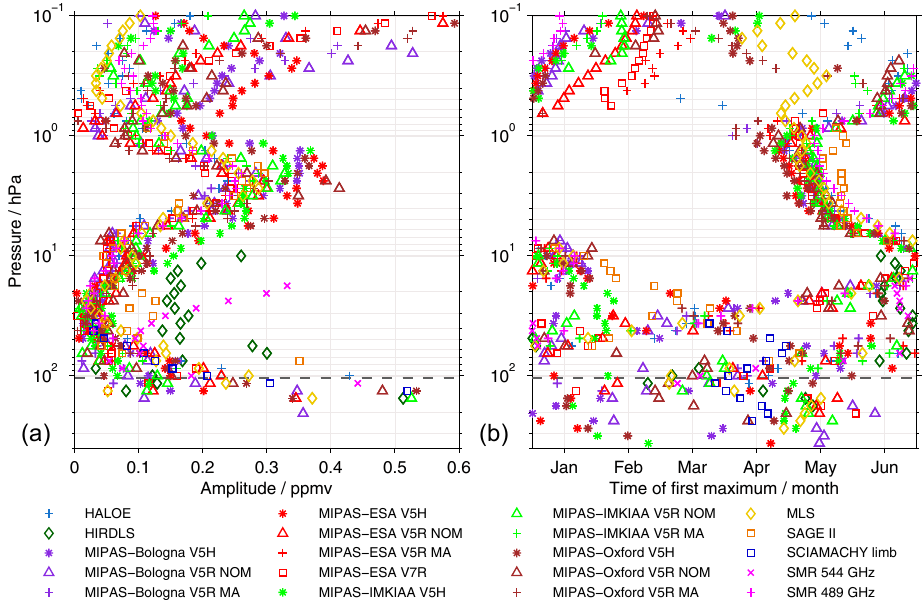
Figure 7. The characteristics of the semi-annual variation in the inner tropics (5 ◦ S–5 ◦ N) as derived from the individual data sets. The left panel shows the amplitude of the semi-annual variation, the right panel shows the phase in terms of the month in which the first water vapour maximum occurs during a calendar year. The average tropopause is marked by the dark grey dashed line.